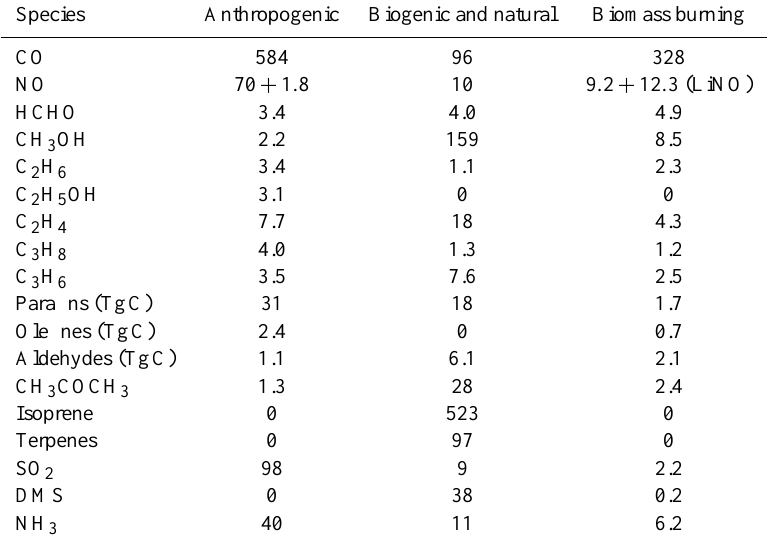
Table 1. Annual emissions from anthropogenic, biogenic and natural sources and biomass burning for 2008 in Tg for a C-IFS (CB05) run at T255 resolution. Anthropogenic NO emissions contain a contribution of 1.8Tg aircraft emissions and 12.3Tg (5.7TgN) lightning emissions (LiNO) is added in the biomass burning columns. Biogenic and